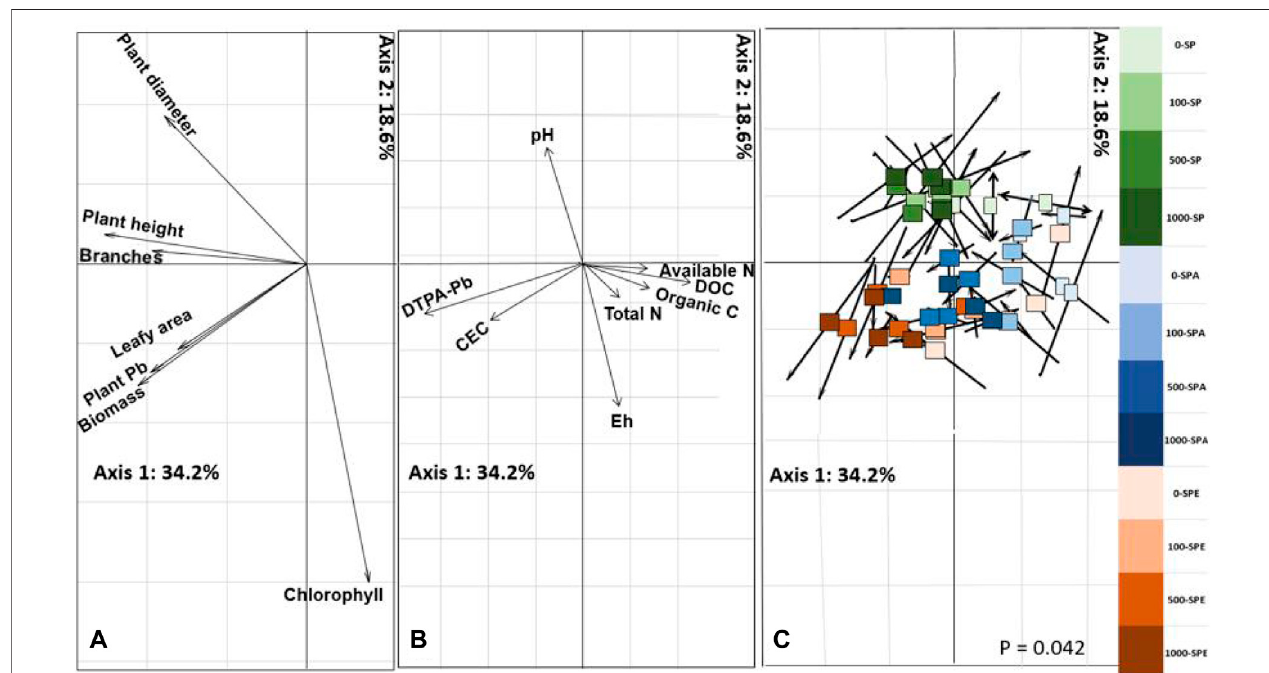
FIGURE5| Co-inertia analysisbetweensoil properties and plant characteristicsinthe differenttreatments. (A) Co-inertia projection ofplantgrowth and Pb uptake properties; (B) Co-inertia projection ofsoil properties; (C) Score plot of treatments; The squaresand arrows represent the projected coordinates of soil physio-chemical properties and plant growth parameters and Pb accumulation of each pot. DOC: dissolved organic carbon; CEC: cation exchange capacity. SP: Brassica campestris was grown, SPA: B. campestris was grown and A. aspergillum was inoculated , SPE: B. campestris was grown and E. fetida was inoculated. Pb contamination levels include 0, 100, 500, and 1,000 mg kg − 1